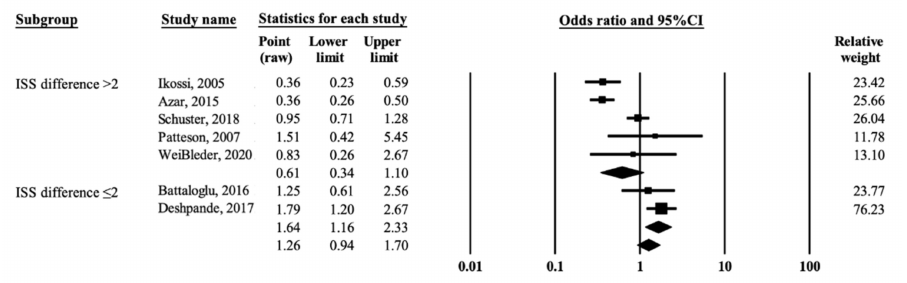
Figure 3. Forest plot of odds ratio for mortality from motor vehicle crashes in association with pregnancy according to differences in ISS between comparison groups [5–7,9,11,17,18]. The black squares represent the odds ratios of the individual studies and the horizontal lines are their 95% CI. The area of the black squares and diamond respectively reflects the weight each trial contributes and the overall effect from the